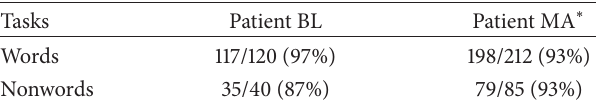
Table 2: Patients’ performance in reading words and nonwords (correct responses).